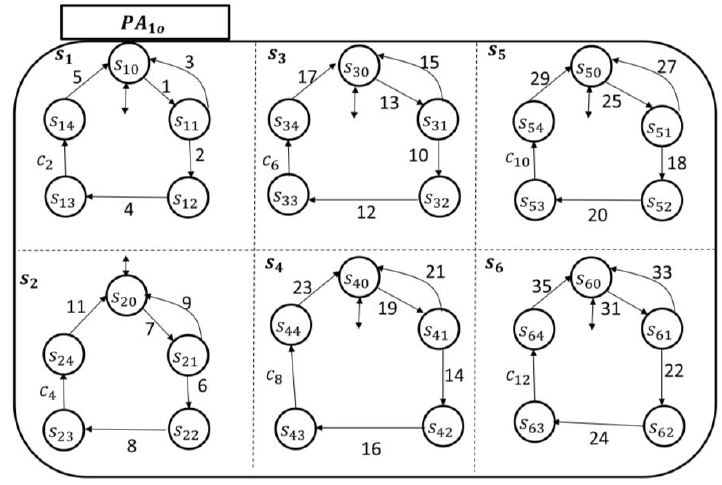
Figure 12. Patient automaton 𝑷𝑨 𝟏𝒐 transitional model.